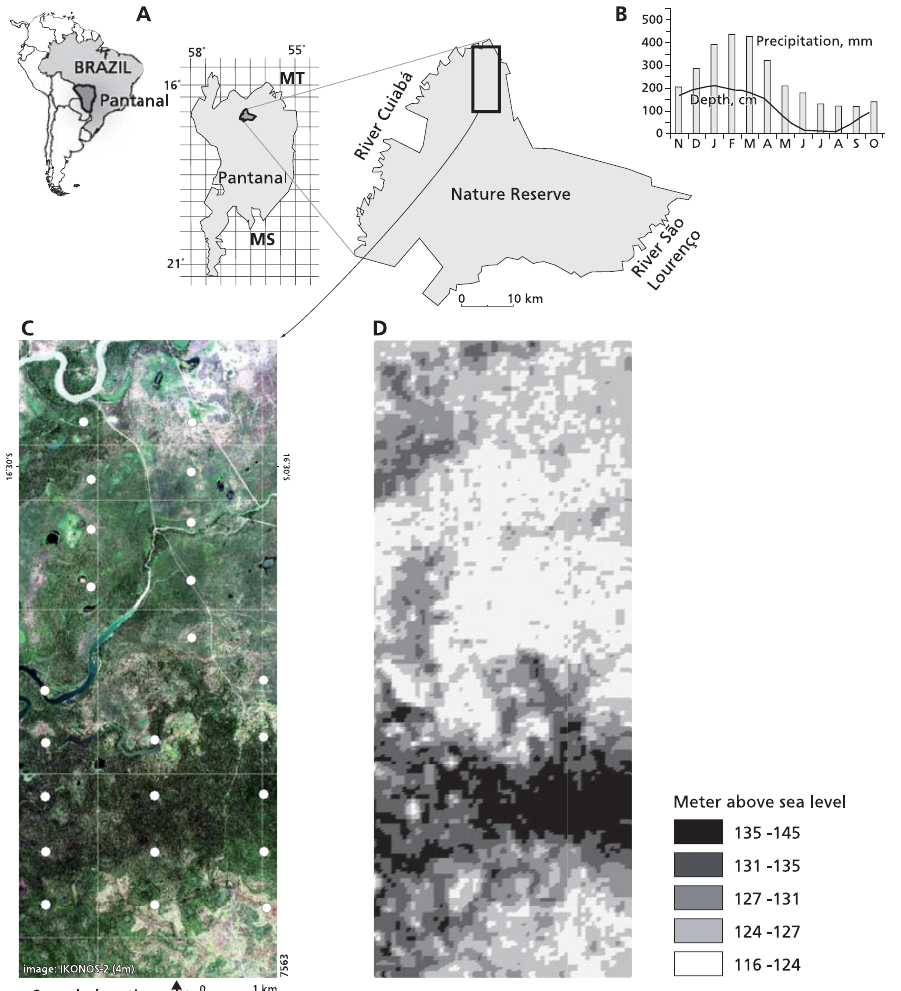
Fig. 1. Study site. (A) Natural Reserve SESC Pantanal located at the Pantanal Mato-grossense, Mato Grosso; Brazil; (B) mean annual water depth fluctuation of the River Cuiab´a (1963–2000) and mean precipitation near Cuiab´a, northern Pantanal. Rainfall data from INMET (National Institute of Meteorology of Brazil), river level data from DNAEE (National Department of Waters and Electric Energy of Brazil); (C) four meter resolution multispectral IKONOS-2 image, of the study site acquired in October 2003, true color. White circles are the sam- pling locations; (D) 90-m Resolution SRTM (NASA Shuttle Radar Topographic Mission, http://www2.jpl.nasa.gov/srtm/) Digital Elevation Model of the study